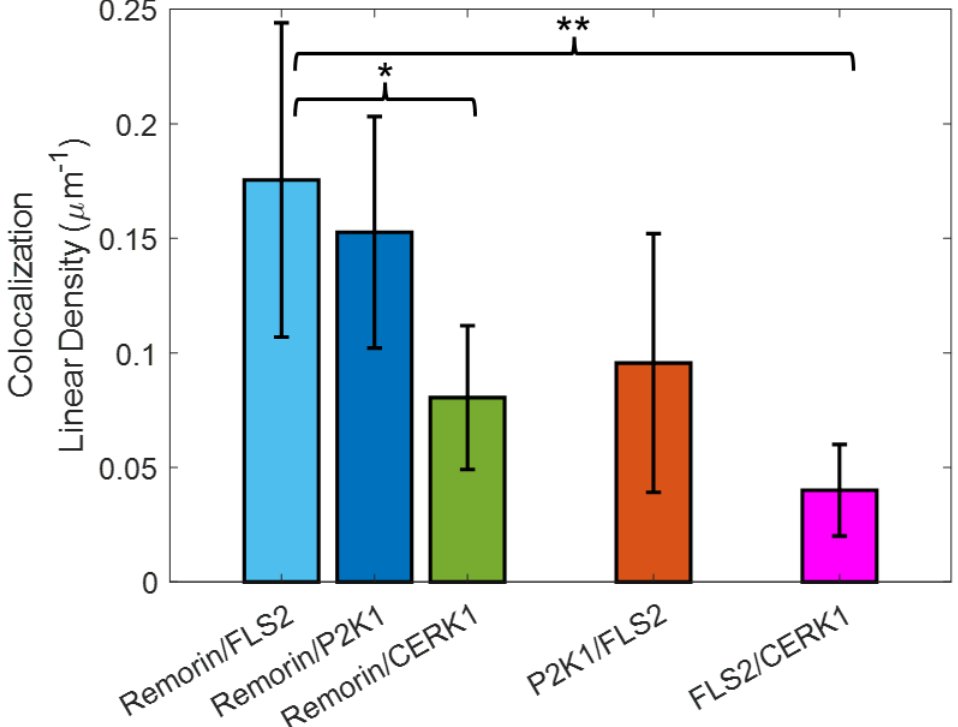
Figure 5. The linear density of colocalization within 100 nm of various pairs of membrane proteins along the root hair membrane. * p < 0.05, ** p < 0.01.